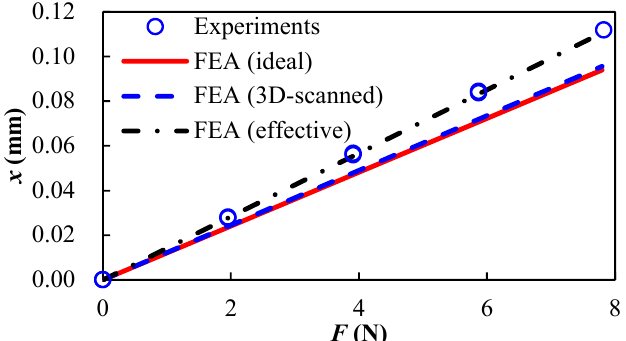
Figure 4. Force-displacement results of the LBM additive-manufactured flexure parallel mechanism by experimental tests and finite element analysis.